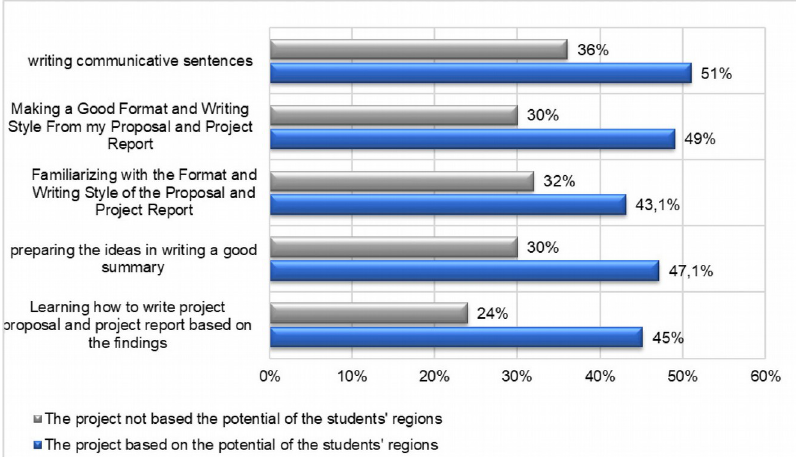
Figure 5. The comparison of the percentage for students who agreed on Communication